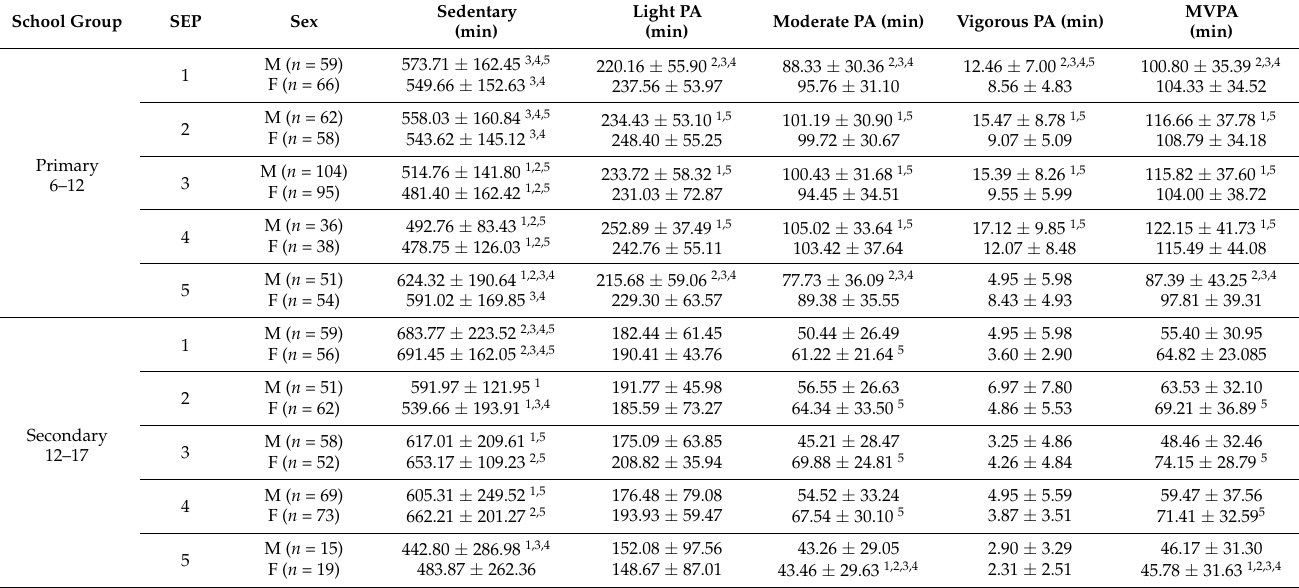
Table 6. Results of the daily PA analysis in each SEP level divided by sex and school level